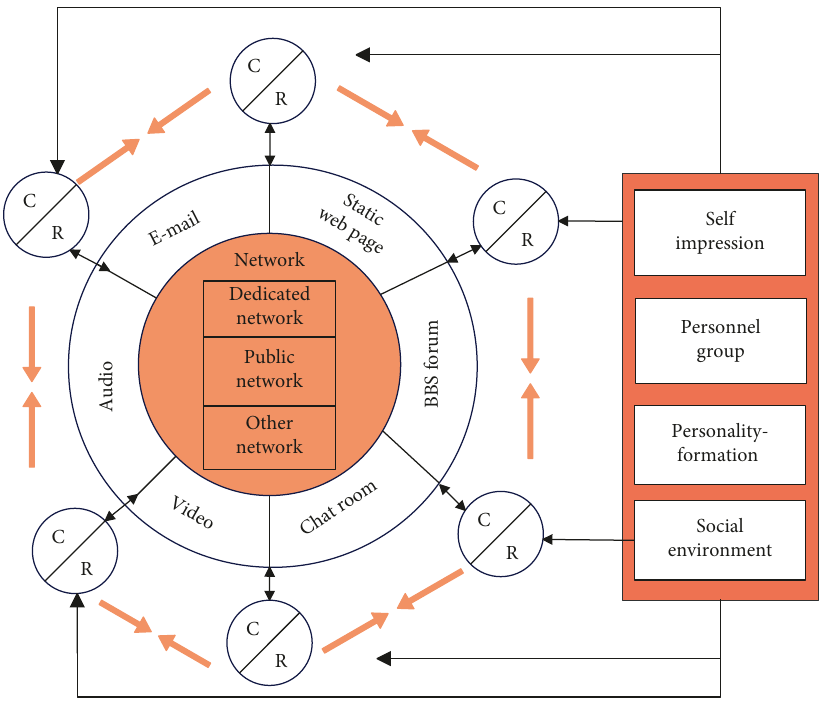
Figure 3: Six degrees of propagation